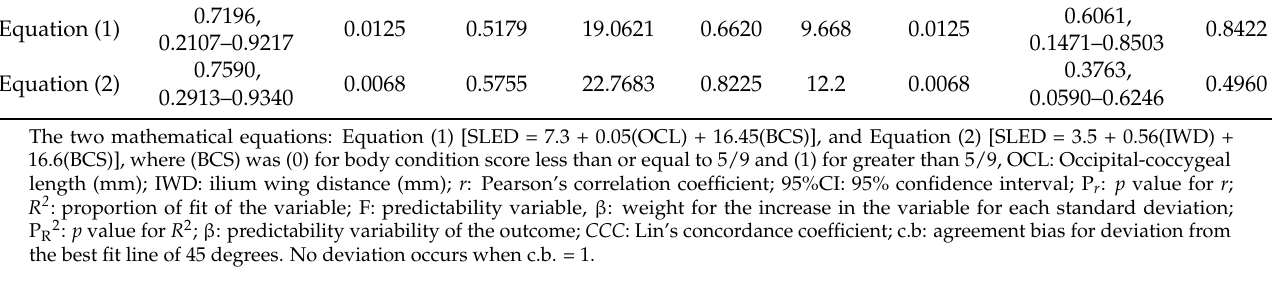
Table 2. Correlation and concordance relationships between the true skin to lumbosacral epidural distance (SLED), and two mathematically derived lumbosacral epidural distances from 11 canine cadavers. SLED